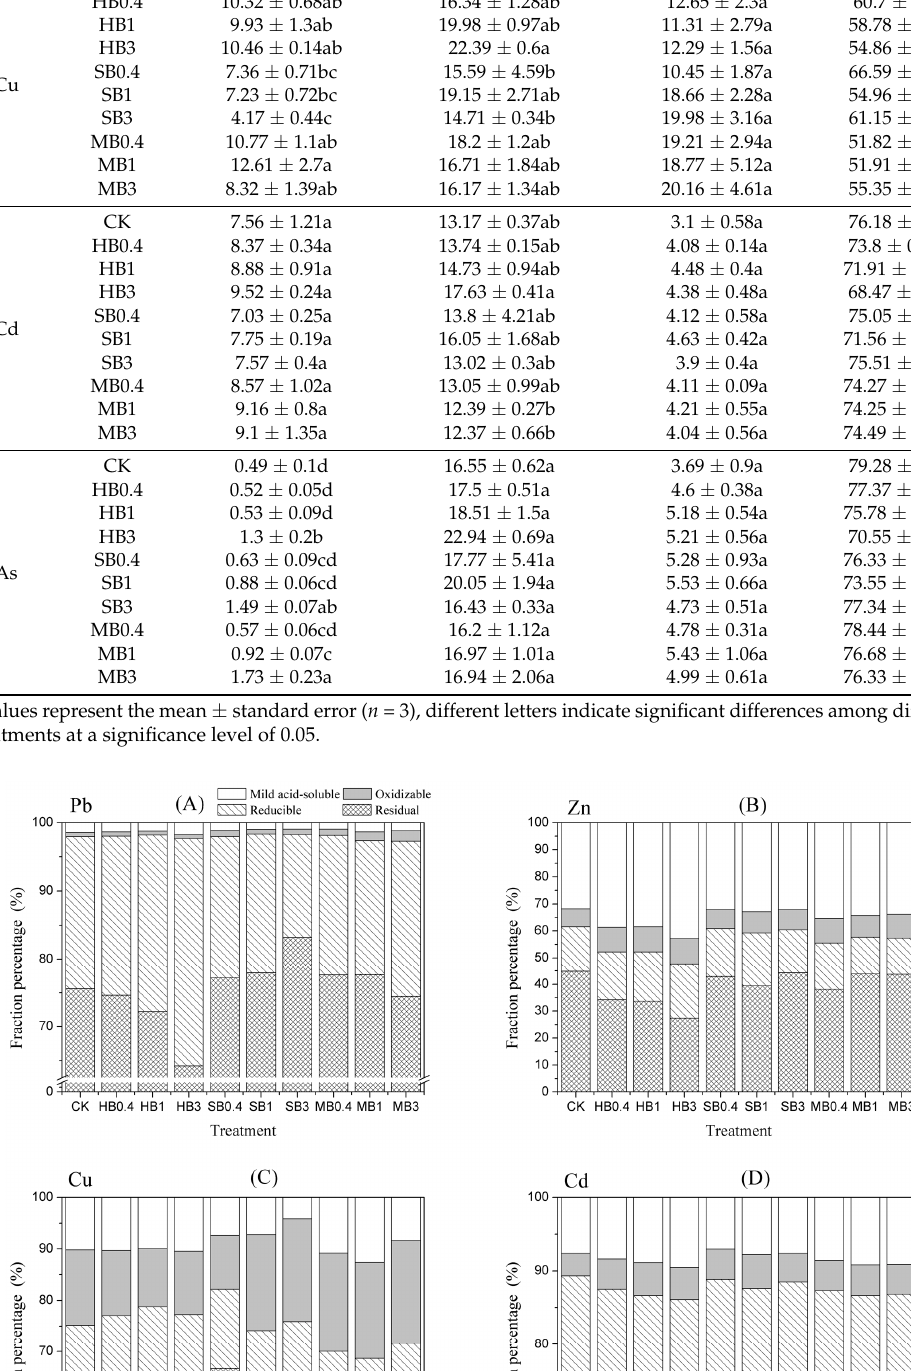
Figure 3. Effects of HB, SB and MB treatments on chemical fractionation of ( A ) Pb, ( B ) Zn, ( C ) Cu, ( D ) Cd and ( E ) As in mine tailings ( n = 3). CK, HB/SB/MB0.4, HB/SB/MB1 and HB/SB/MB3 refer to no biochar input and the incorporation of biochar into the soil at 0.4%, 1% and 3% by mass, respectively. HB: Hibiscus cannabinus core biochar; SB: sewage sludge biochar; MB:chicken manure biochar.